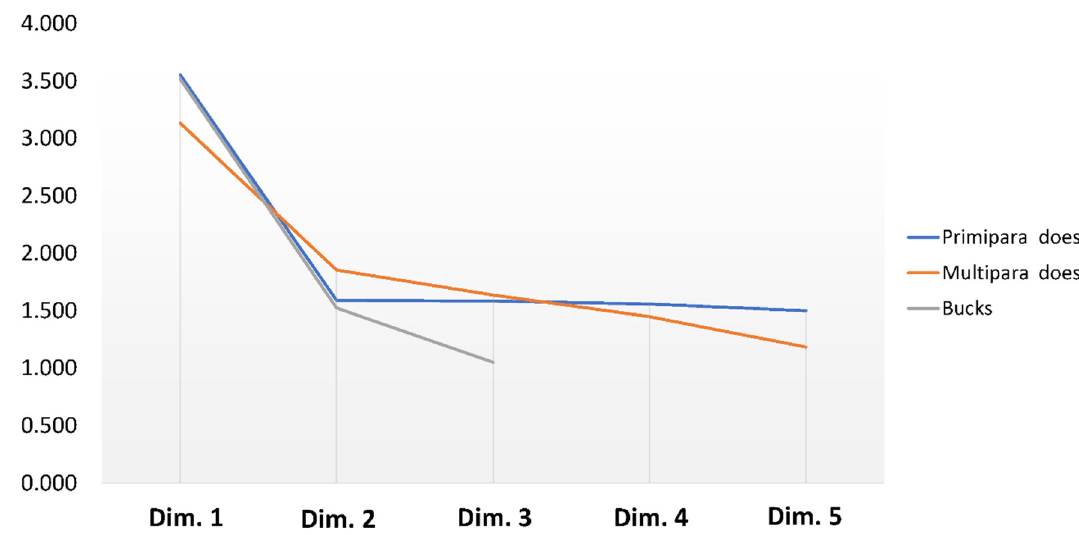
Figure 1. Representation of principal component analysis (PCA) eigenvalues for dimensions 1 to 5 (Dim. 1–5) for LAS scores in Murciano-Granadina primipara and multipara does and dimensions 1 to 3 in bucks. Table 2. LAS varimax with Kaiser normalization rotated component loadings, eigenvalues and percentages of variance explained for Murciano-Granadina primipara and multipara does.